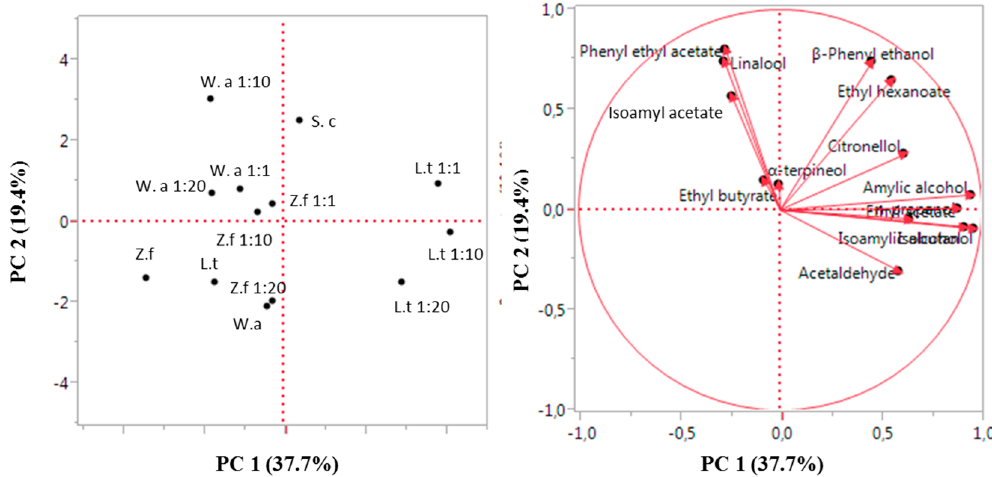
Figure 4. Principal component analysis for the main by-products and volatile compounds of the pure non-conventional yeasts (L. t = L. thermotolerans ; W. a = W. anomalus ; Z. f = Z. florentina ) and their mixed fermentations with S. cerevisiae (S. c). The variance explained by principle component analysis (PCA) analysis is PC 1 37.7% X-axis and PC 2 19.4% Y-axis). PC 1: principal